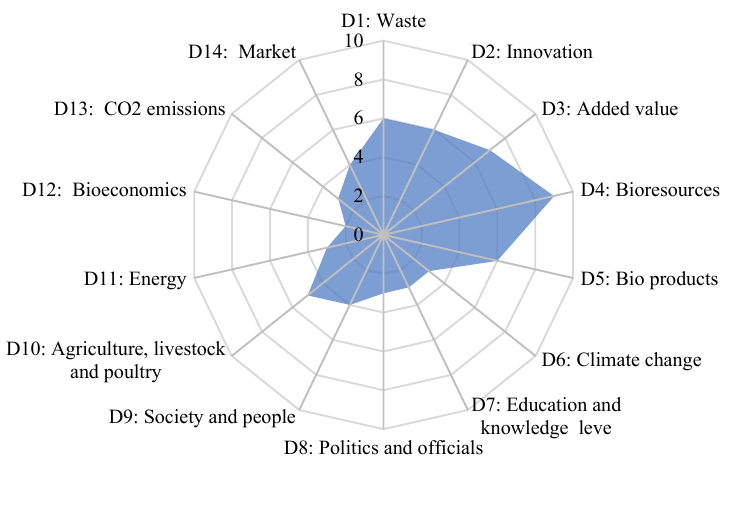
Fig. 2. Bioeconomy indicators with the highest rating. T ABLE 1. N UMBER OF S ELECTED V ARIABLES AND C ATEGORIES FOR A LL R ESPONDENT Number of selected